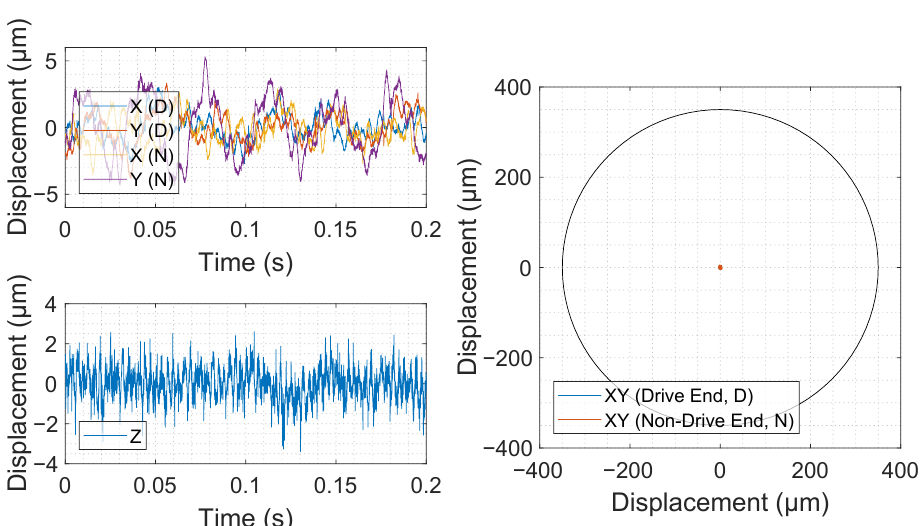
Figure 12. Rotor displacement measurement signals fed to the rotor position controller of the magnetic bearing system from two inductive displacement sensors while the rotor is levitated and rotating at 1200 r/min. Note: The difference from the measurement signals presented in Figure 11 is the removal from the controller input of harmonic content synchronous to the rotational